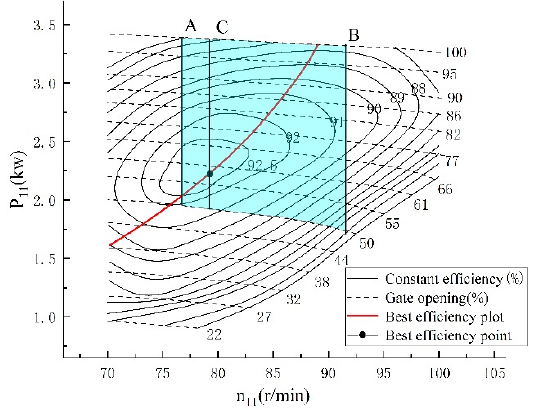
Figure 16. Hill diagram of the model pump-turbine.